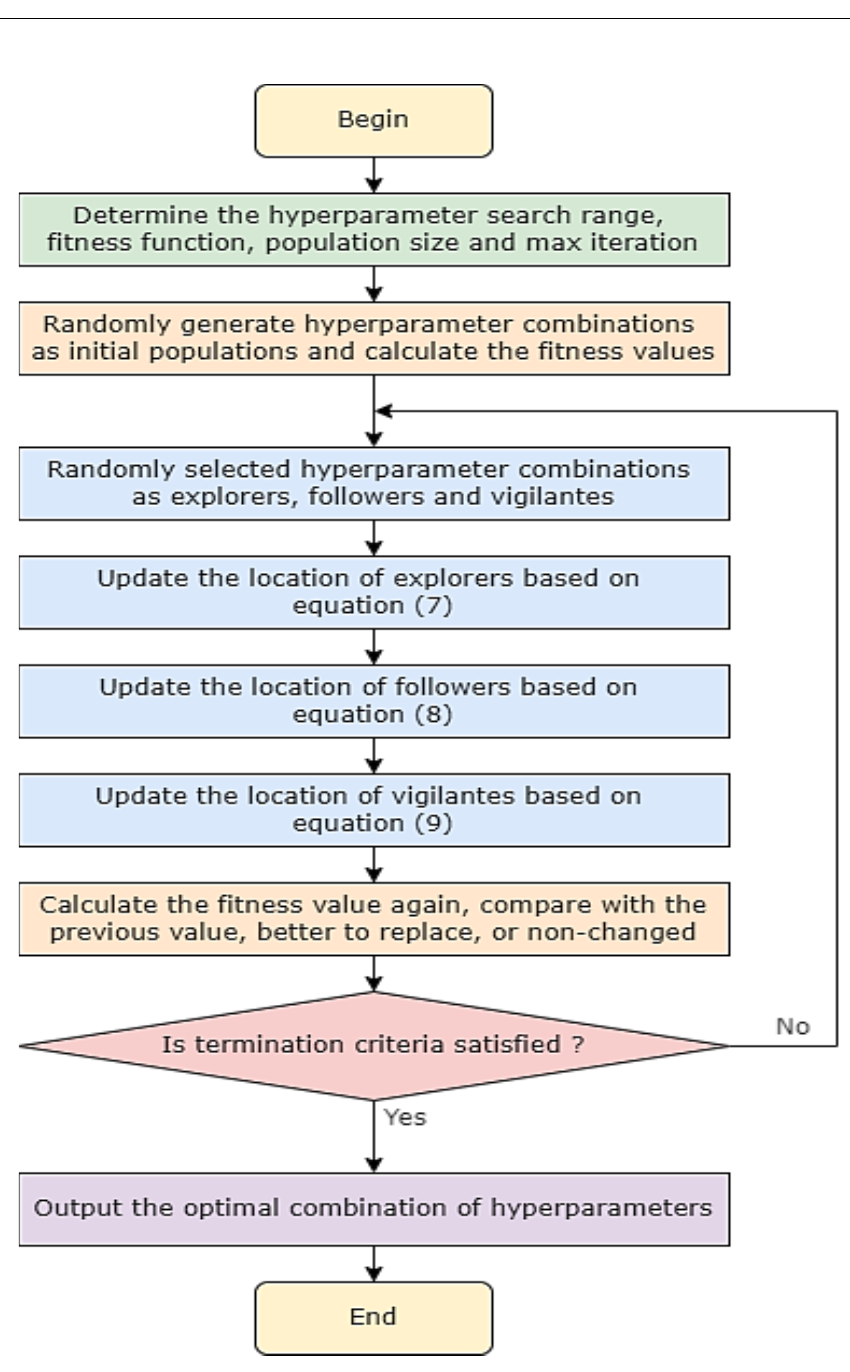
Figure 3. The flowchart of SSA-BLS.